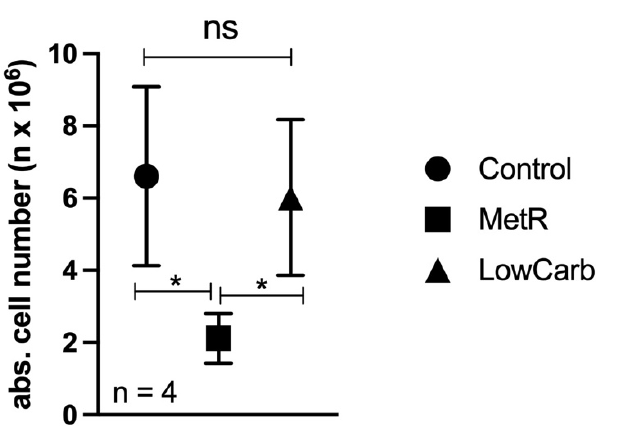
Figure 6. Final cell number in perfusion culture under different conditions. Towards the end of the experiment, the absolute cell number of each Petri dish was determined using an EVE TM automated cell counter. The mean values of the four experiments and the respective range of cell counts are plotted here. Comparisons between the control and MetR groups were performed by applying one-way ANOVA followed by the Tukey–Kramer multiple comparison test (* p < 0.05, ns = not significant).